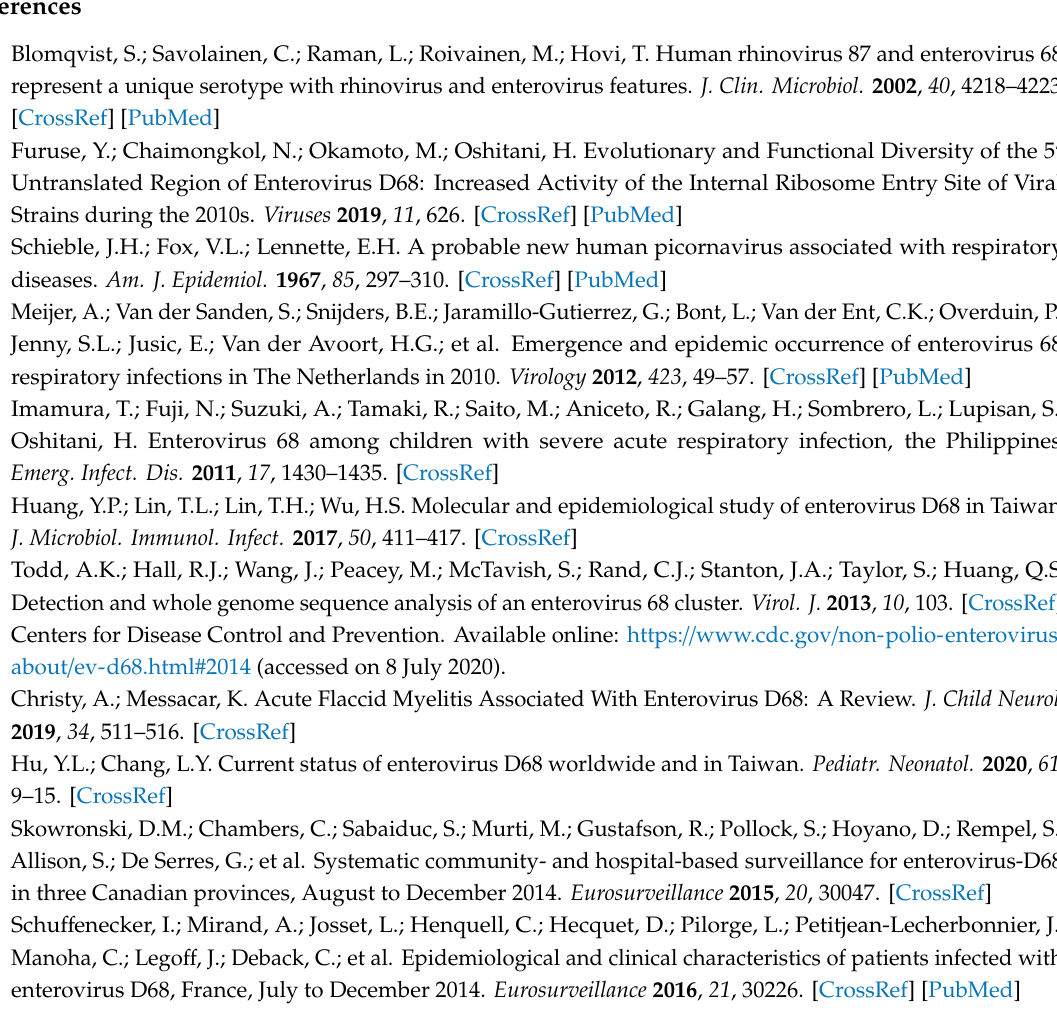
Table S1: Primer sequence for the construction of infectious cDNA clones, Data S1: Alignment of 5 (cid:48) -UTR sequences, Data S2: Alignment of polypeptide